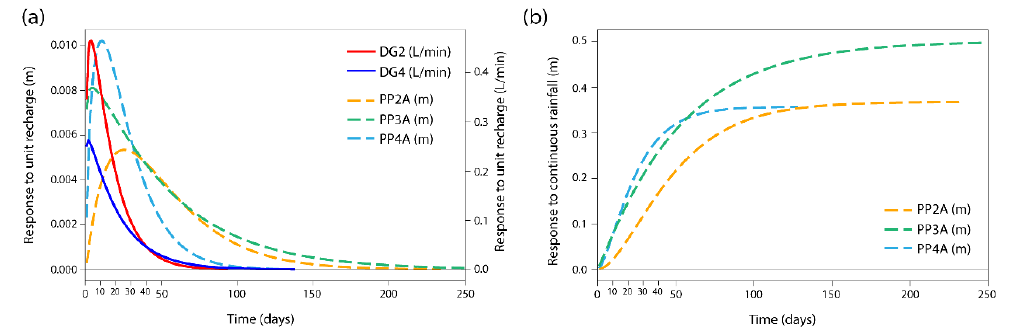
Figure 7. The impulse responses ( a ) for piezometers PP2A, PP3A, and PP4A, and drain groups 2 (DG2) and 4 (DG4); and the step responses ( b ) for piezometers PP2A, PP3A, and PP4A.